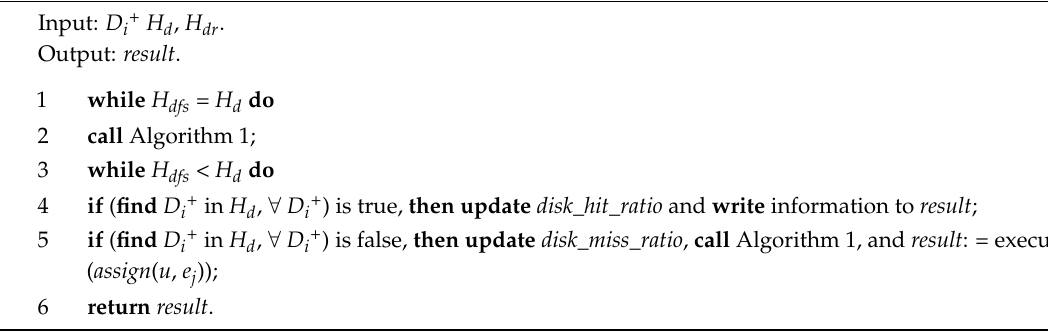
Algorithm 7. Visit current data (hit or miss) in the disk